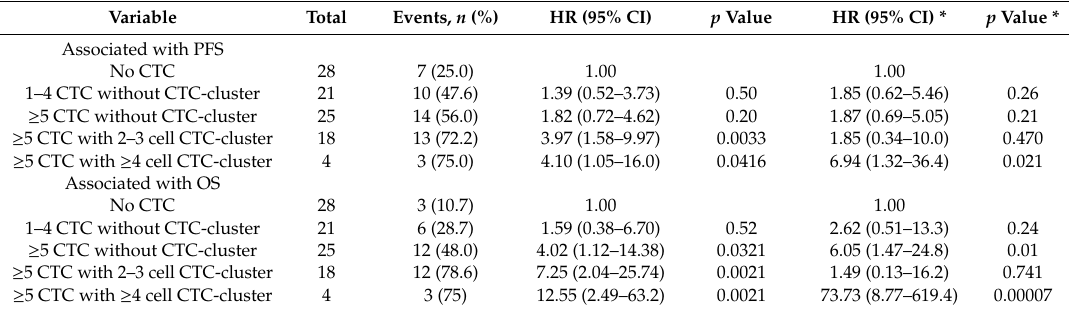
Figure 5. Longitudinal analysis for CTCs and CTC-clusters in relation to patient outcome. Kaplan–Meier curves displaying PFS and OS of patients without CTCs, patients with 1–4 CTC without CTC-clusters, patients with ≥ 5 CTCs without CTC-clusters and patients ≥ 5 CTCs with CTC-clusters ( a , b ). The predictive value of CTC-cluster size was also analyzed. Kaplan–Meier curves displaying PFS and OS of patients with 1–4 CTC without CTC-clusters, patients with ≥ 5 CTCs without CTC-clusters, patients ≥ 5 CTCs with 2–3 cell CTC-clusters, and patients ≥ 5 CTCs with 4 cell CTC-clusters ( c , d ). Bar graph showing the percentage of patients positive for CTCs having single CTCs only (black), CTC-clusters during one time point (light gray), and CTC-clusters across two time points (dark grey) ( e ). Kaplan–Meier curves displaying PFS and OS of patients with single CTCs only, patients with CTC-clusters during one time point, and patients with CTC-clusters across two time points ( f , g ). Table 5. Longitudinal changes in CTCs and CTC-clusters in relation to PFS and